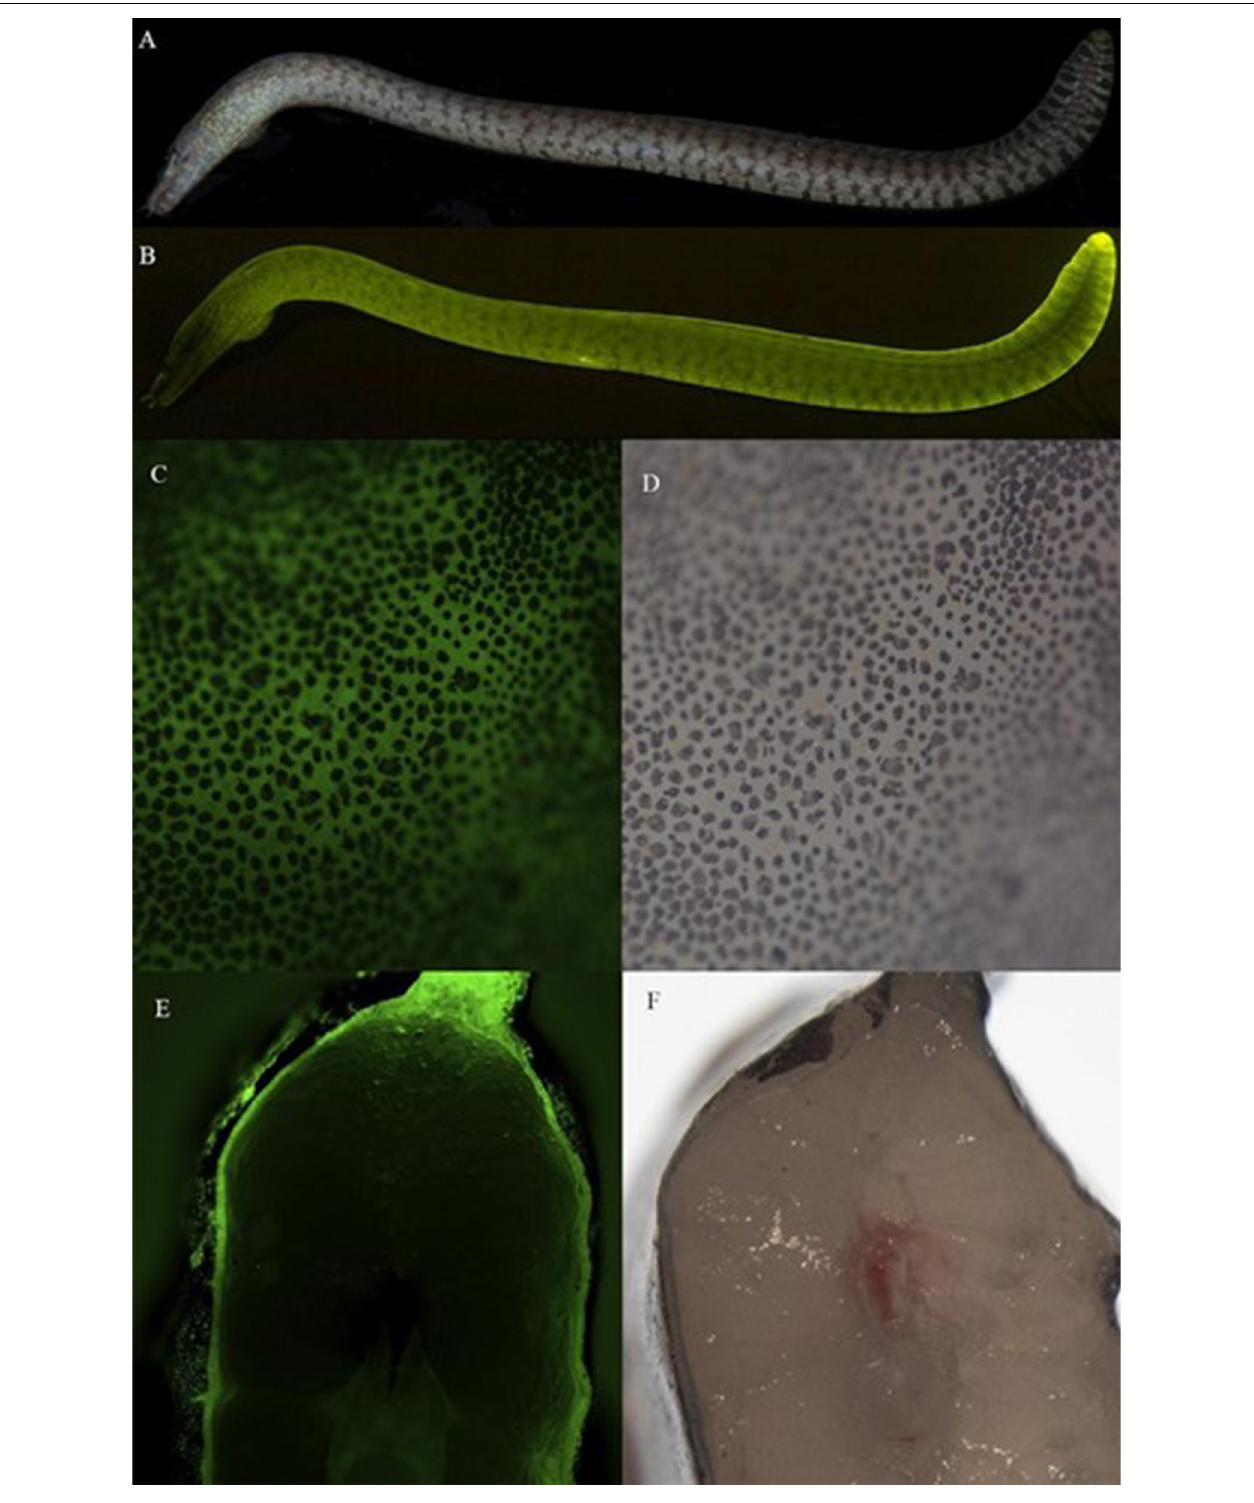
FIGURE 1 | Details of green fluorescence of Gymnothorax zonipectis (AMNH 277097, 151 mm SL). (A) White light and (B) fluorescent emission photo of Gymnothorax zonipectis . (C,D) Close up of epidermis revealing dark pigmented regions (chromatophores) interspersed with green fluorescence arising from below the skin, and (E,F) cross-section through the mid body demonstrating fluorescence below the skin. Muraenids (morays), like most anguilliform eels, lack scales.